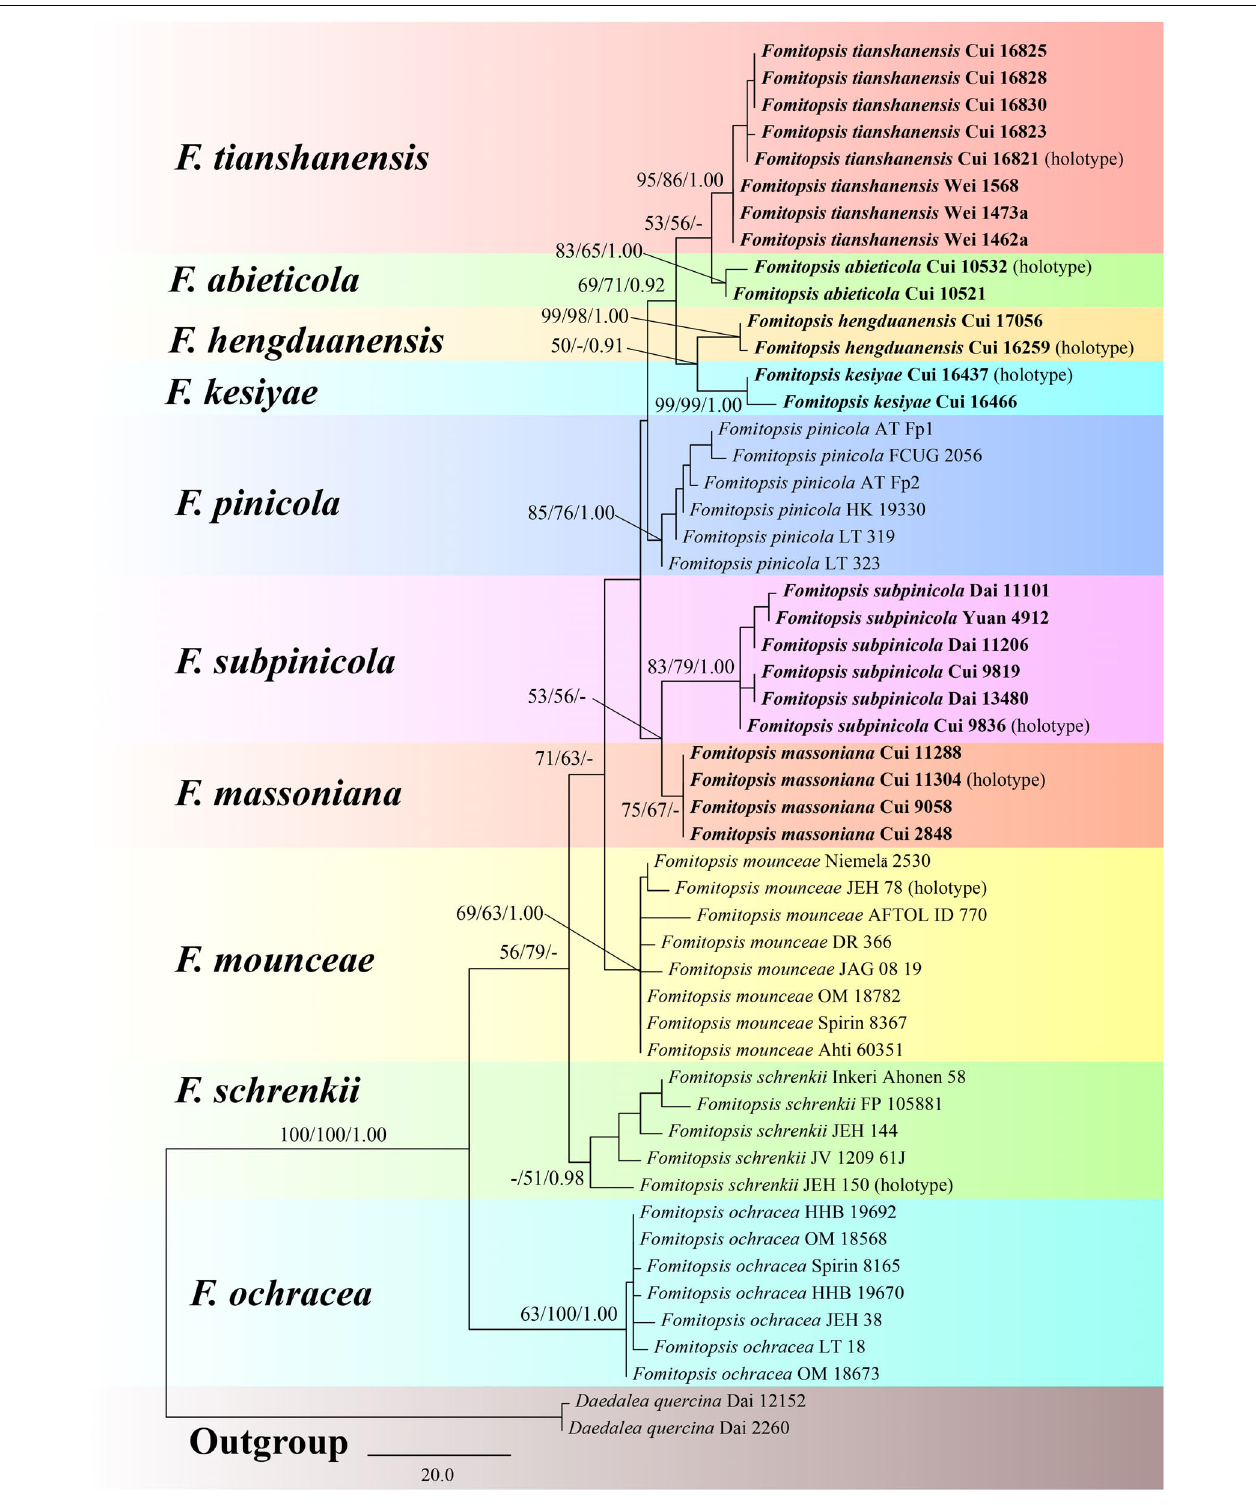
FIGURE 1 | Maximum parsimony tree illustrating the phylogeny of the Fomitopsis pinicola complex based on the combined sequences dataset of ITS + RPB2 + TEF. Daedalea quercina served as the outgroup. Branches are labeled with maximum likelihood bootstrap higher than 50%, maximum parsimony bootstrap proportions higher than 50% and Bayesian posterior probabilities more than 0.95. Bold names = New species.